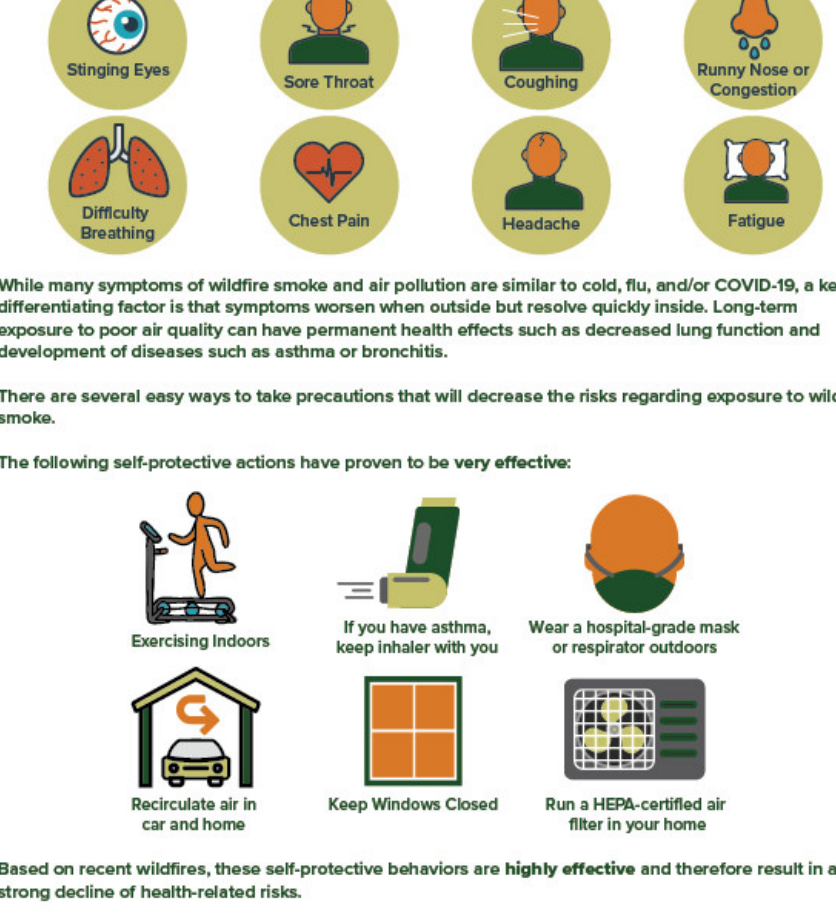
Figure A3. High-efficacy, visual-based Stimuli.